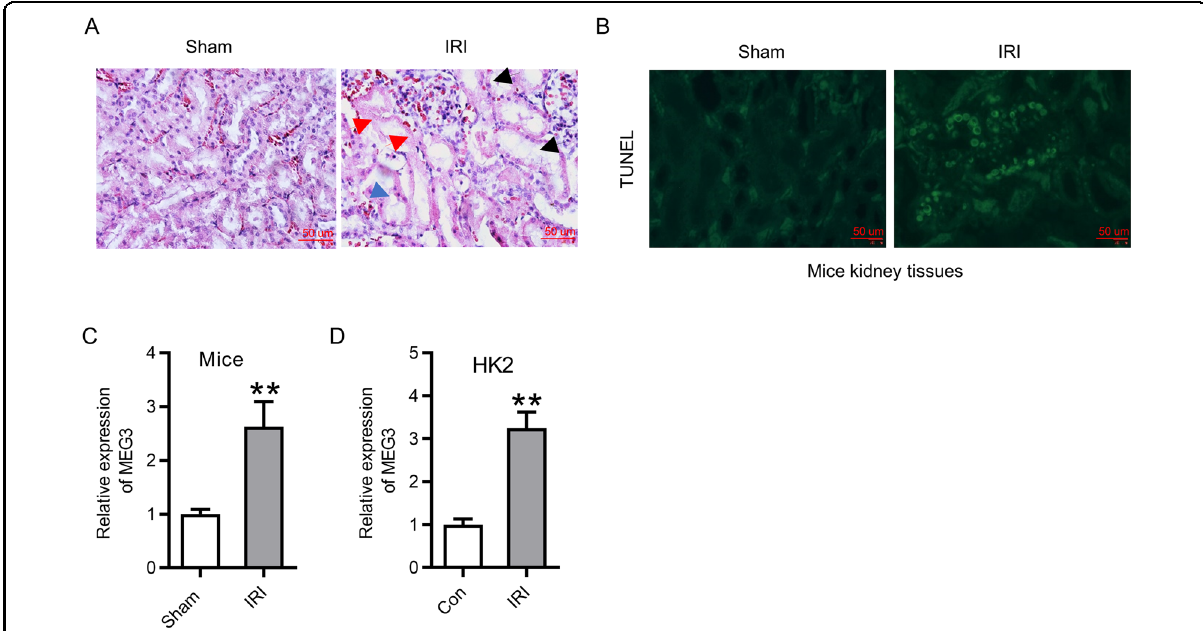
Fig. 1 MEG3 exhibited high expression after IRI. A H&E staining revealed IR triggered tubular injury. B TUNEL assay revealed the apoptosis cells induced by IRI in mice kidney tissues. Red arrow indicates coagulative necrosis with tubular structures; black arrow indicates renal tubule vacuole; blue arrow indicates renal tubular necrosis and detachment. C RT-qPCR revealed expression of MEG3 over a 12-h post IRI in renal cortex of mice compared with that in the sham group. D RT-qPCR revealed the expression of MEG3 in HK-2 cells 6 h following IRI. ** p <